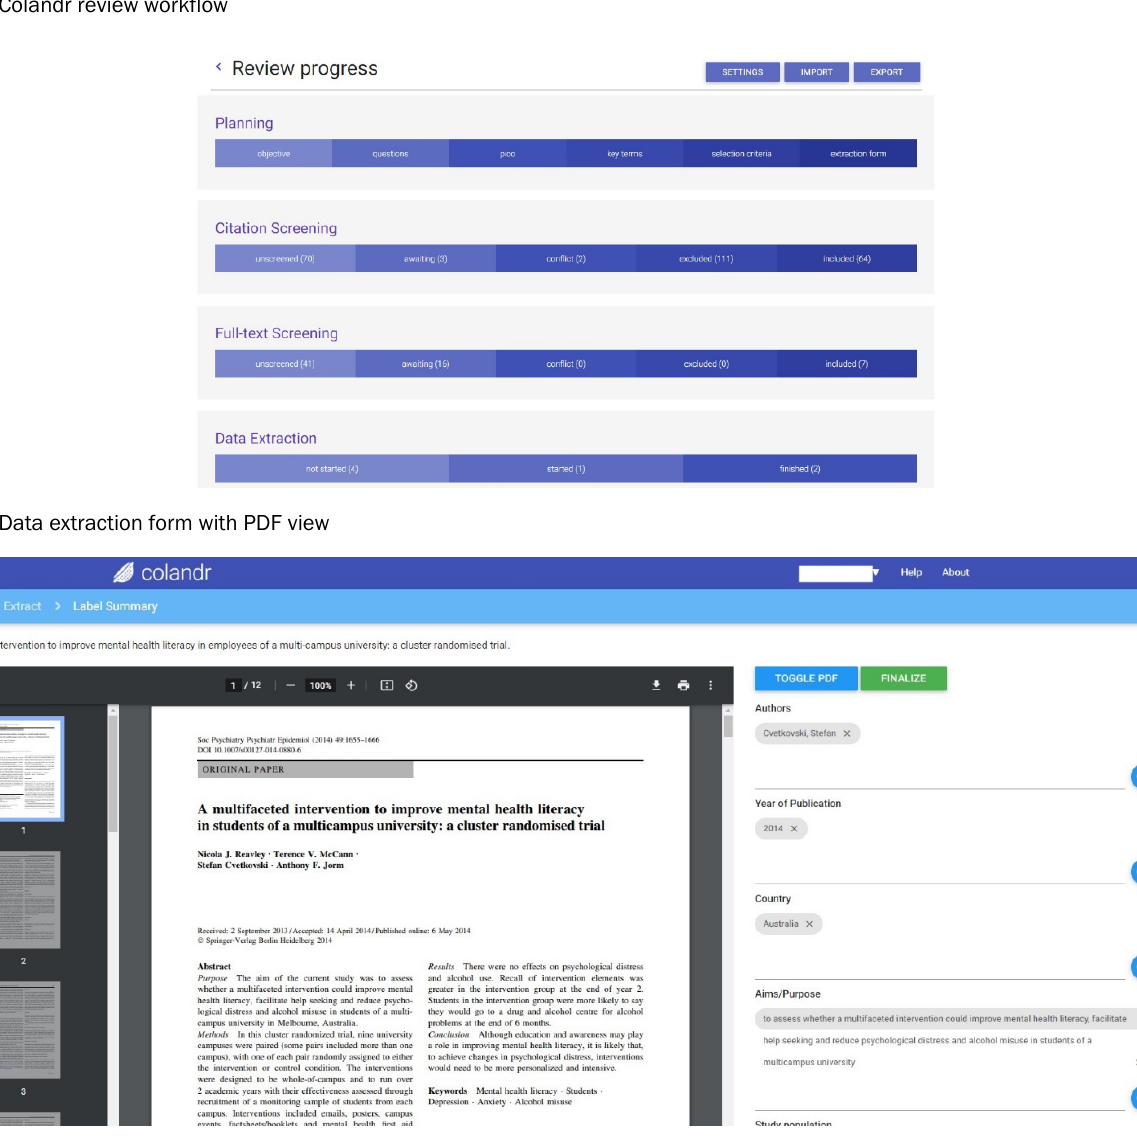
Figure 1 Colandr review workflow